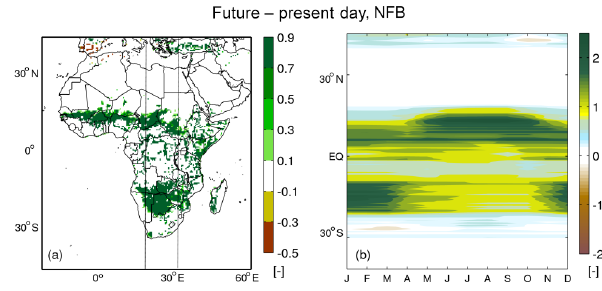
Figure 4. (a) Change in forest fraction and (b) seasonal change in zonal mean forest LAI in the longitude band between 18 and 30 ◦ E (lines in a ), calculated as future minus present day in the FB experiment. Present-day and future periods are defined in Sect.